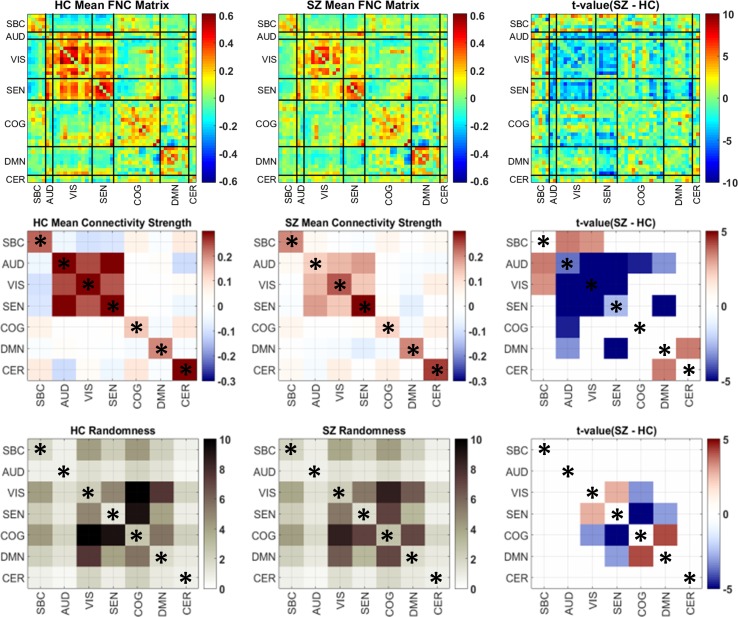
Group mean and differences in connectivity strength and randomness matrices. The first row displays the original FNC matrices for each group and the t values comparing the two groups. Domain submatrices are delimited by black lines. Because domain analysis estimates one single value per submatrix, it is easier to illustrate each submatrix value using squares of the same size. Thus, submatrix size is ignored in the second and third rows only for illustration purposes. The number of submatrix elements for significant results are included in
Tables 1
 and
2
. The last column portrays only significant t values after Gaussianity transformation (Lilliefors test) and false discovery rate (FDR) multiple comparison correction. Domains have been named as sub-cortical (SBC), auditory (AUD), visual (VIS), sensorimotor (SEN), cognitive control (COG), default-mode network (DMN), and cerebellum (CER). Within domain results are marked by an asterisk.